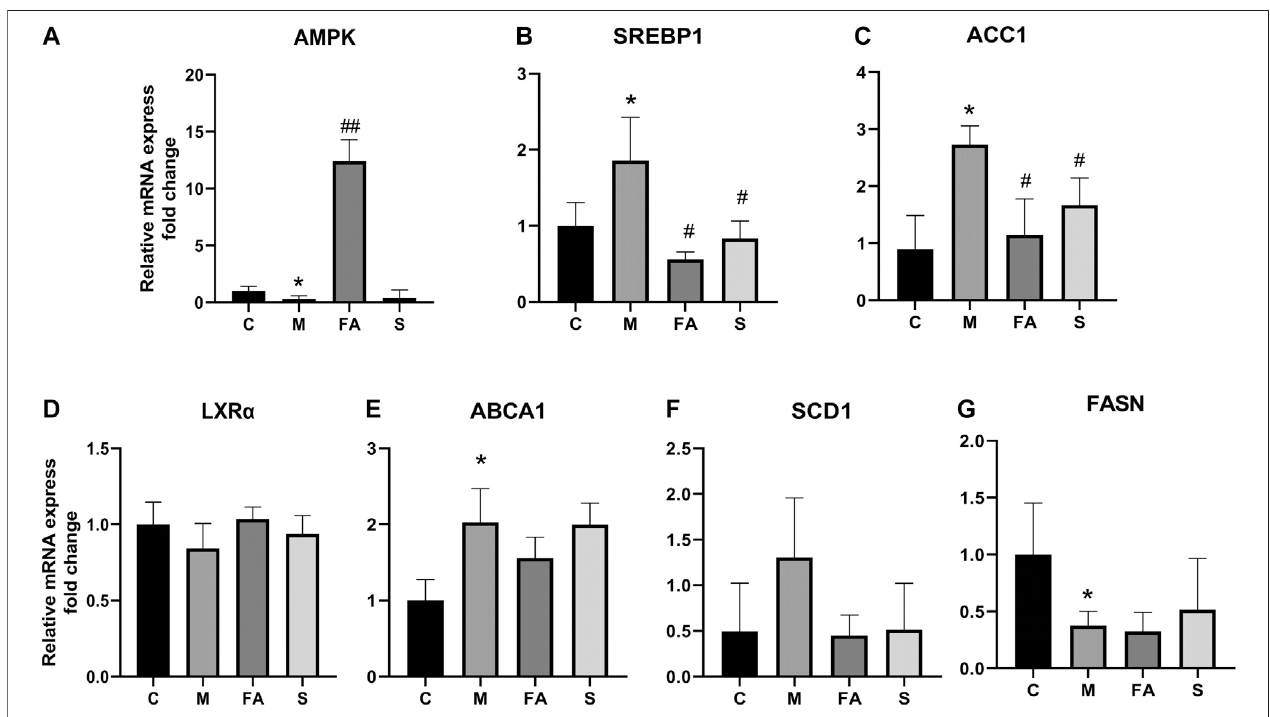
FIGURE 4 | The effect of FA on lipid metabolism related genes in liver (A) – (G) Relative mRNA expression of genes related to lipid metabolism in the liver, including LXR α , ABCA1, AMPK, SREBP1, ACC1, SCD1, FASN ( n (cid:2) 4). * p < 0.05; as compared to the control group. # p < 0.05, ## p < 0.01; as compared to the model group.